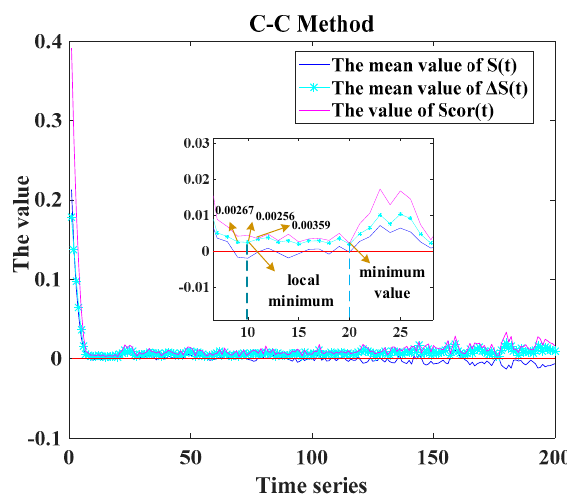
Figure 8. Determining the delay time and the time window by using the C-C method.